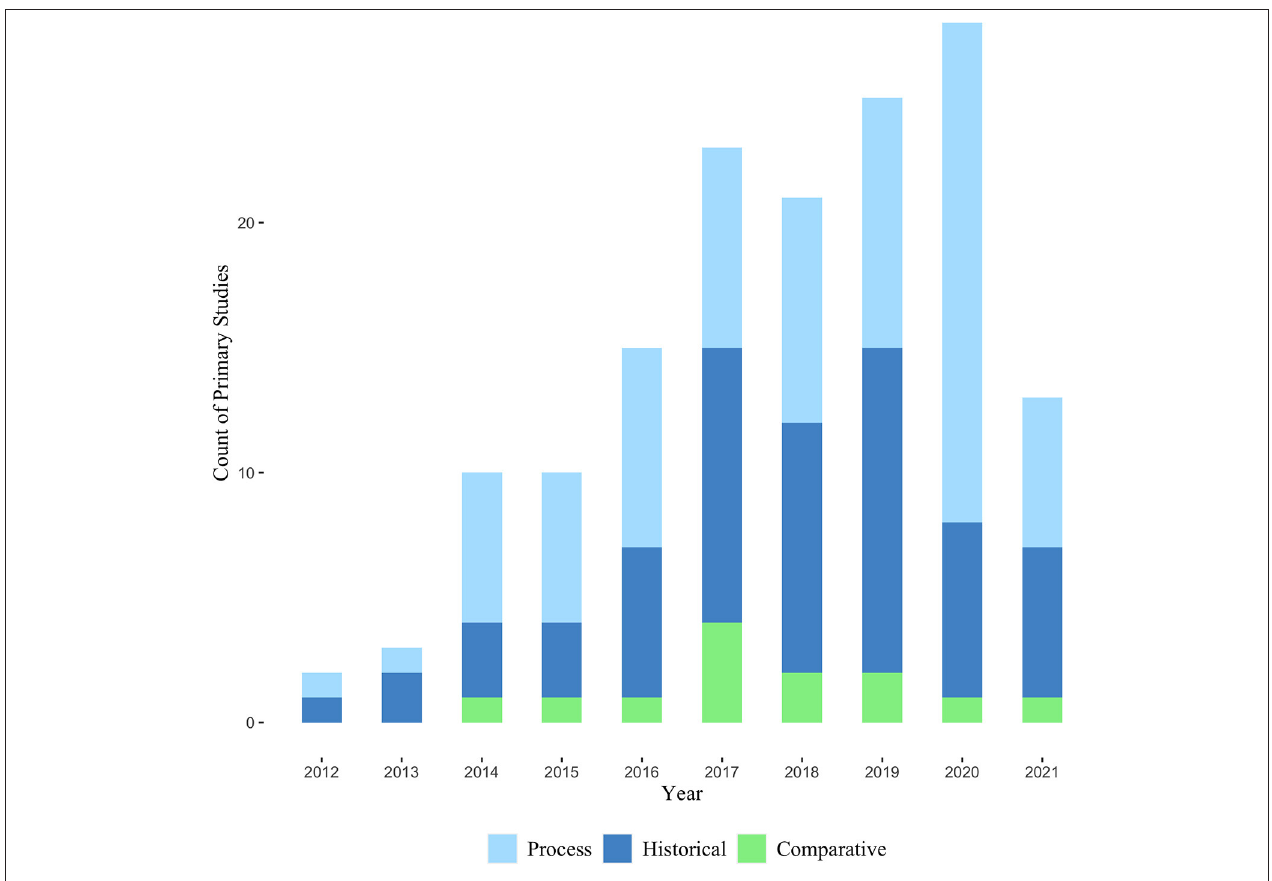
FIGURE 2 | A histogram showing the count of primary study typology over